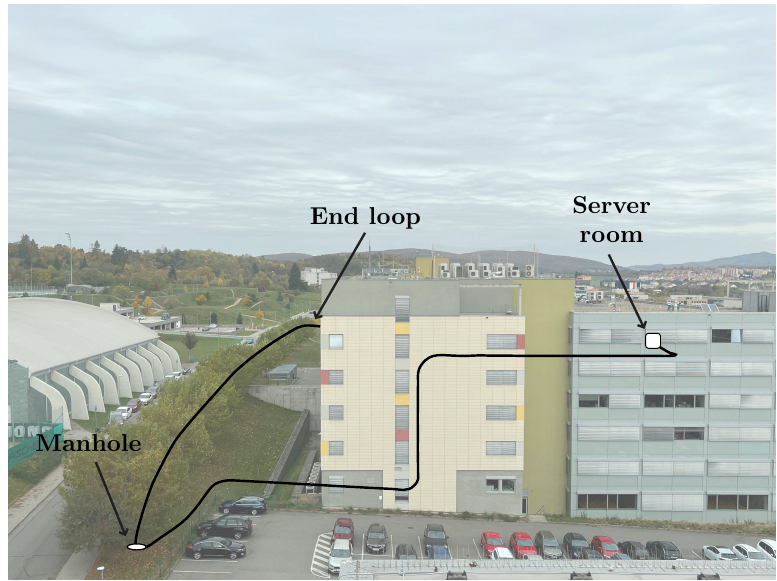
Figure 5. Drawing of a test route on a university polygon used to simulate a real